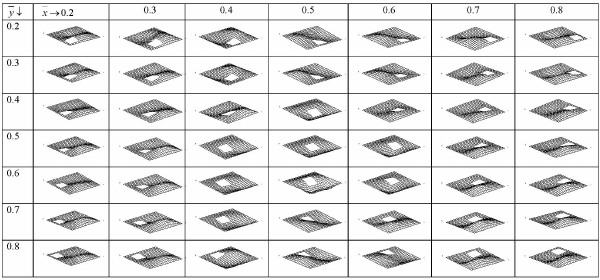
Figure 13: First mode shapes of laminated composite ( + 45/- 45/ + 45/-45) stiffened elliptic parabolic shell for different position of the central square cutout and SSSC boundary